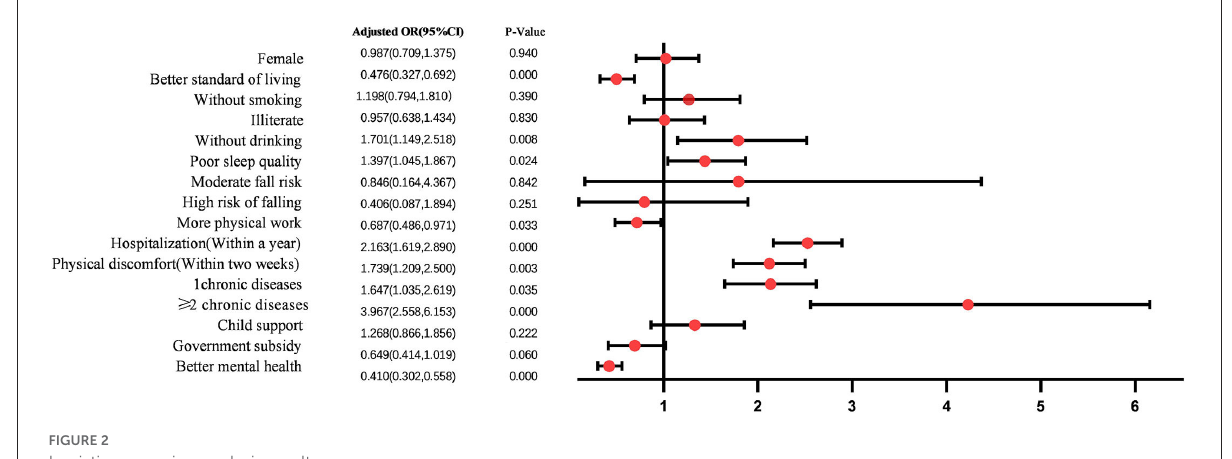
FIGURE2 Logistic regression analysis results.